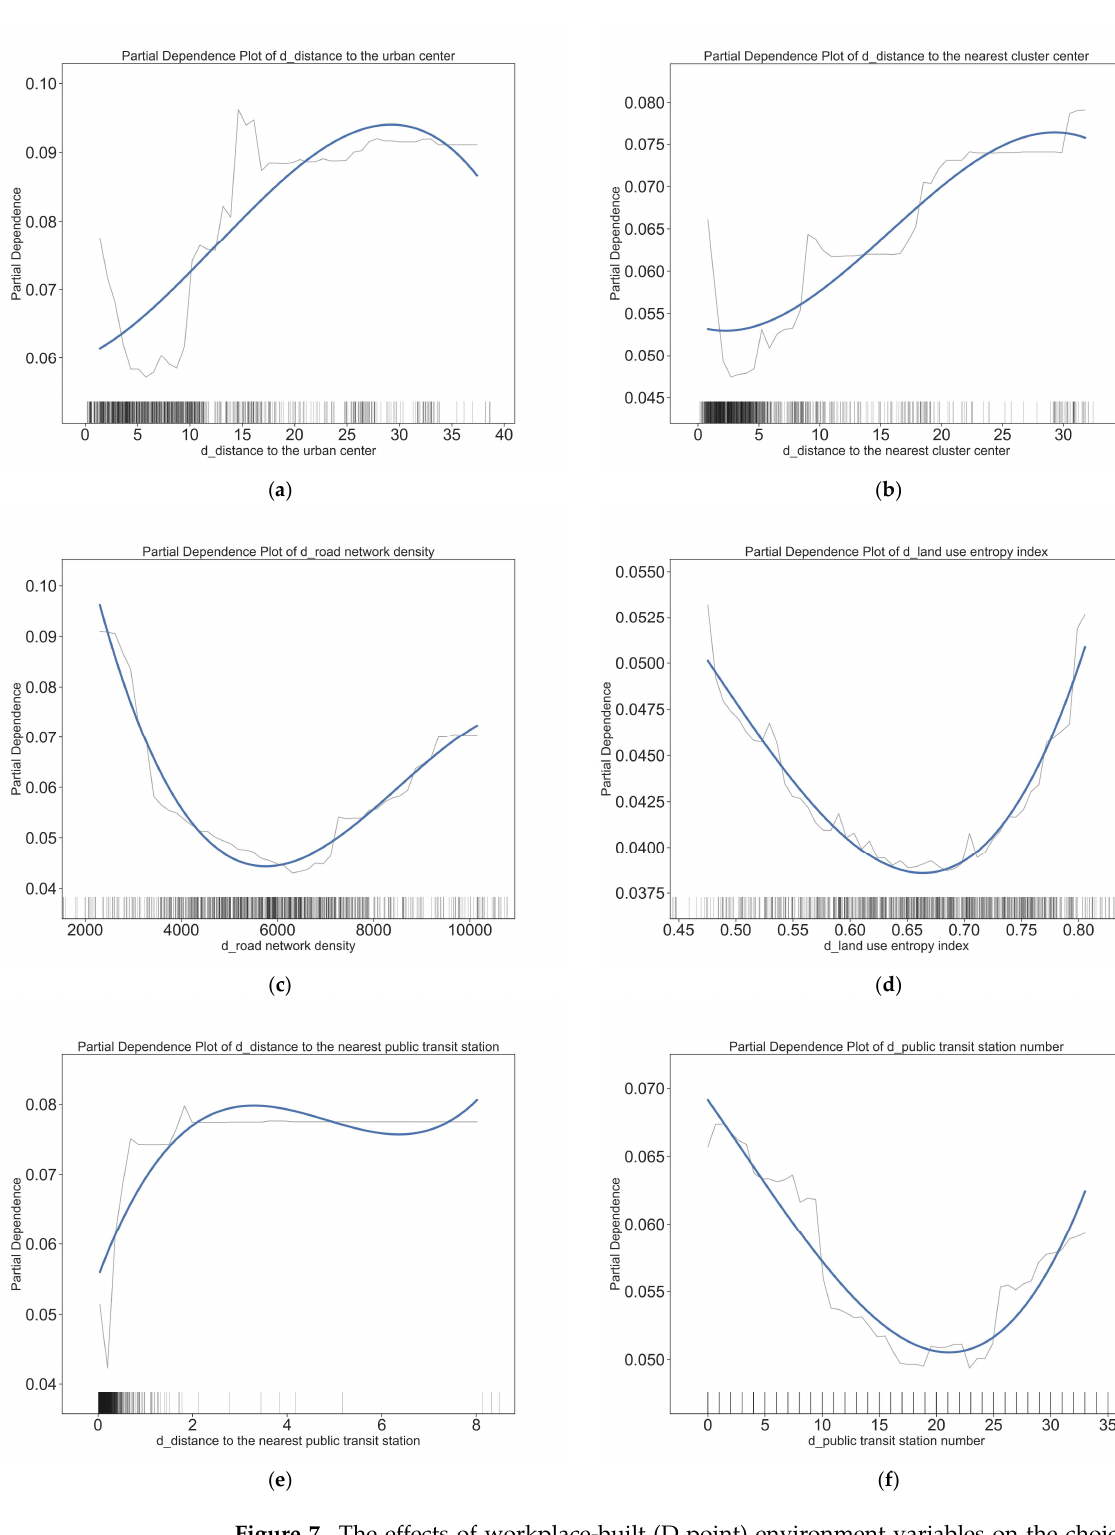
Figure 7. The effects of workplace-built (D point) environment variables on the choice to cycle. ( a ) Impact of distance to the urban center on cycling choices; ( b ) impact of distance to the nearest cluster center on cycling choices; ( c ) impact of road network density on cycling choices; ( d ) impact of land use entropy on cycling choices; ( e ) impact of distance to the nearest public transit station on cycling choices; ( f ) impact of public transit station number on cycling choices.